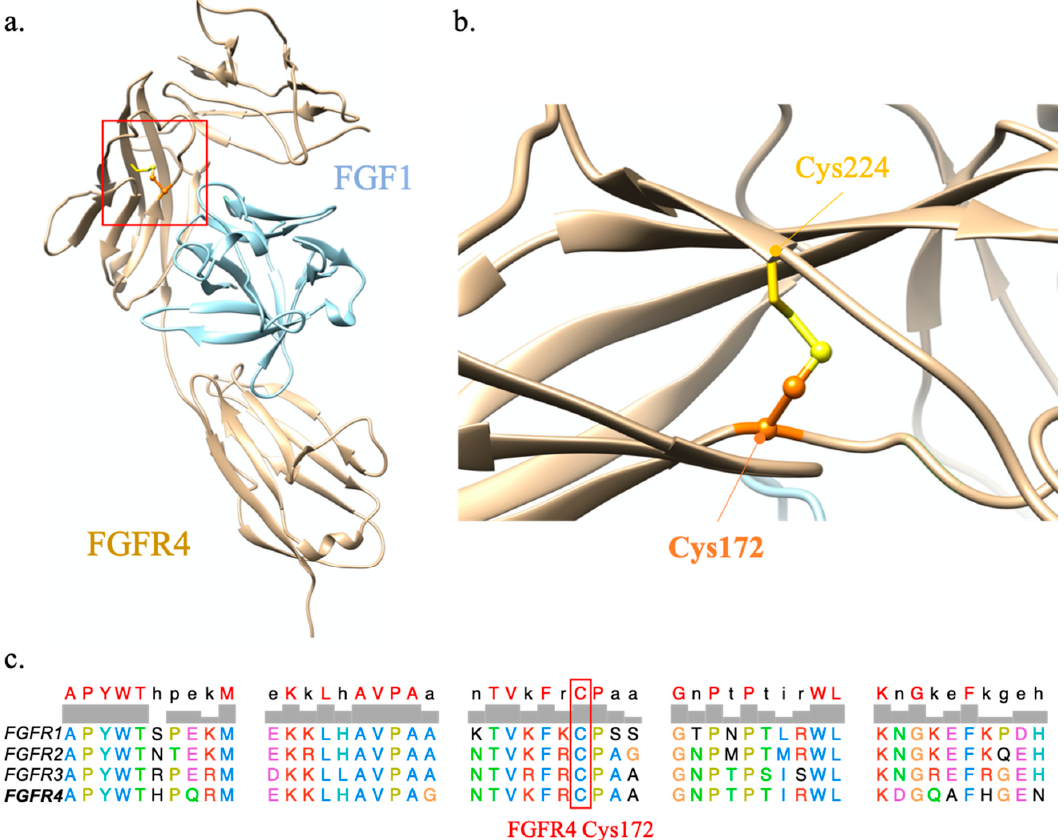
Figure 4. FGFR4 modelling analysis. ( a ) FGFR4 and FGF1 model complex. The red square indicates the region impacted by the FGFR4 p.Cys172Gly mutation; ( b ) zoom on Cys172 and its disulfide bond involving Cys224; ( c ) sequence alignment of the four transmembrane members of the fibroblast growth factor family (FGFR) family. Cys172 is in orange ball-and-sticks and the Cys224 in golden sticks. FGFR4 is in tan ribbon and FGF1 in light blue ribbon (PDB ID 1qct) [21] .